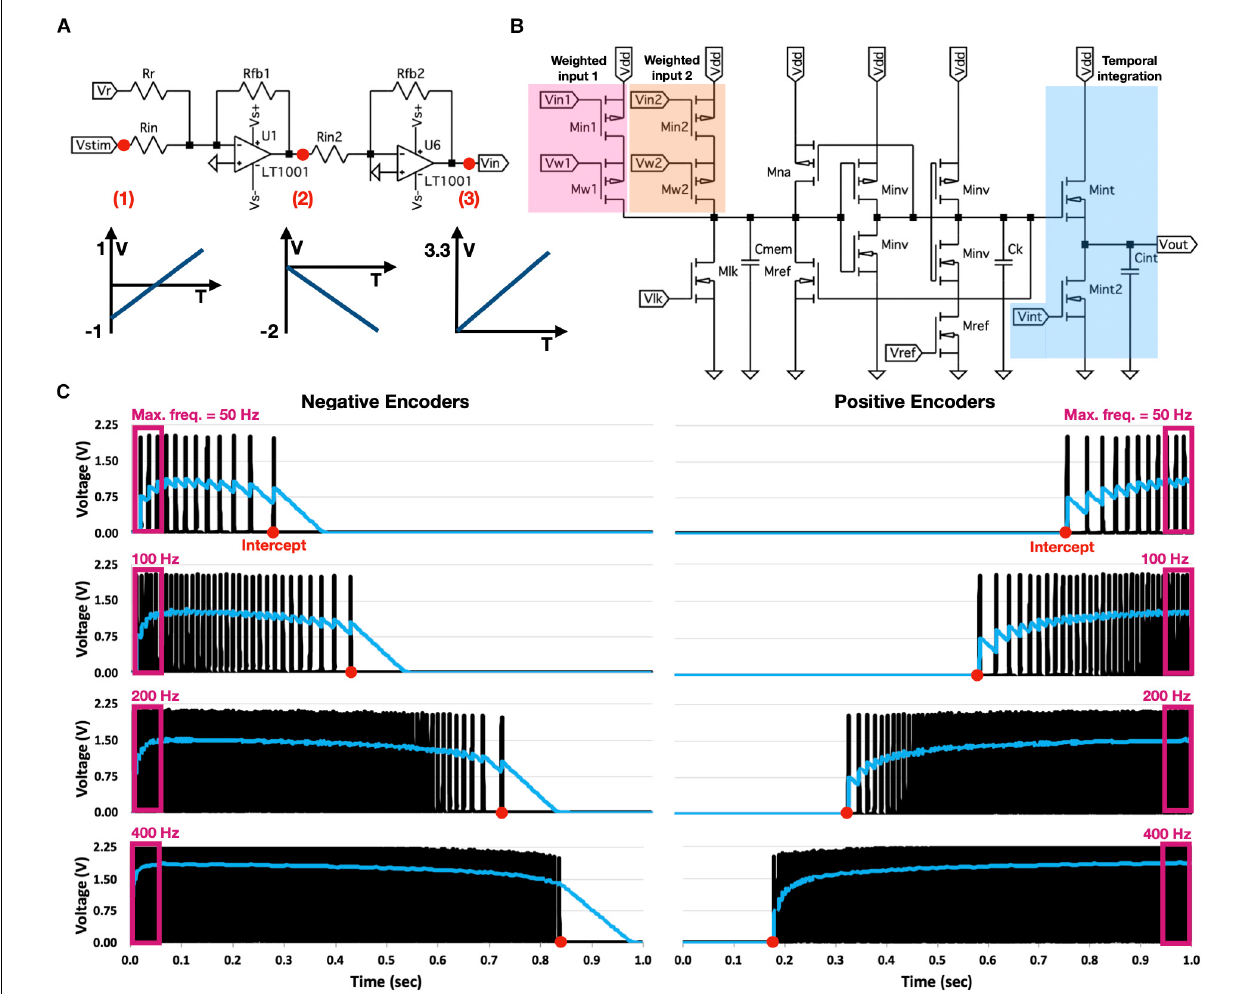
FIGURE 3 | OZ neuron analog design. (A) Preprocessing module for negatively encoded OZ neurons. Module inverses input voltage, aligns it to initiate at 0 V, and reinverts and scales it to terminate at 3.3 V. (B) Neuron’s spike generator. Voltages from two weighted inputs are transformed into a proportional current, injected into a modified voltage-amplifier LIF neuron. Neuron produces a spike train according to its response dynamic. Spike train is introduced into a temporal integration circuit. (C) Eight OZ neurons, four of them are positively encoded (right), and four are negatively encoded (left). All neurons were stimulated with a linearly increasing voltage, rising from –1 to 1 V. Each neuron was modulated with various values of V lk to produce a spike train at a particular rate, starting from a specific input